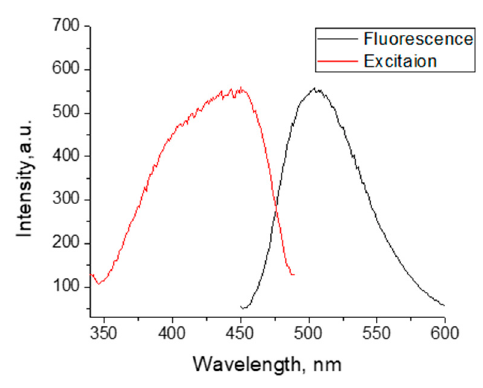
Figure 7. Excitation and fluorescence spectra of poly(St-co-NI3) in thin film (60 μ